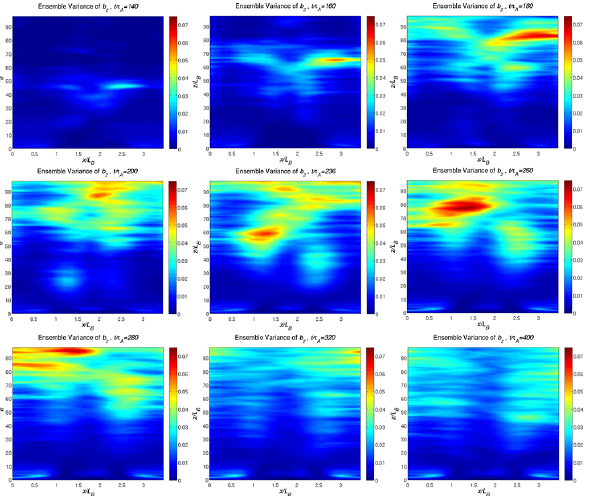
Fig. 7. z component of the magnetic field and, superimposed, the field lines for the reference simulation at different time steps and on the entire simulated domain. The spatial dimensions are normalised to L B , the length scale of variation of the magnetic field. Time is normalised to the Alfvén time τ A , b z is normalised to b 0 .